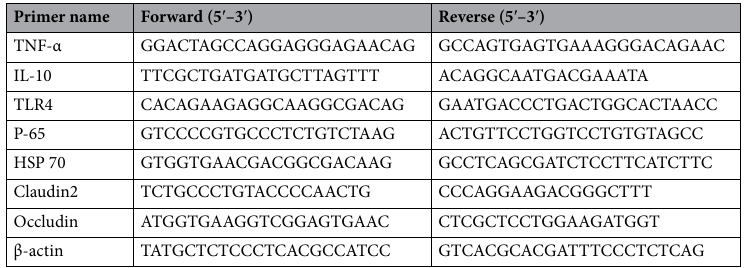
Table 1. Sequence of primer used for detection of